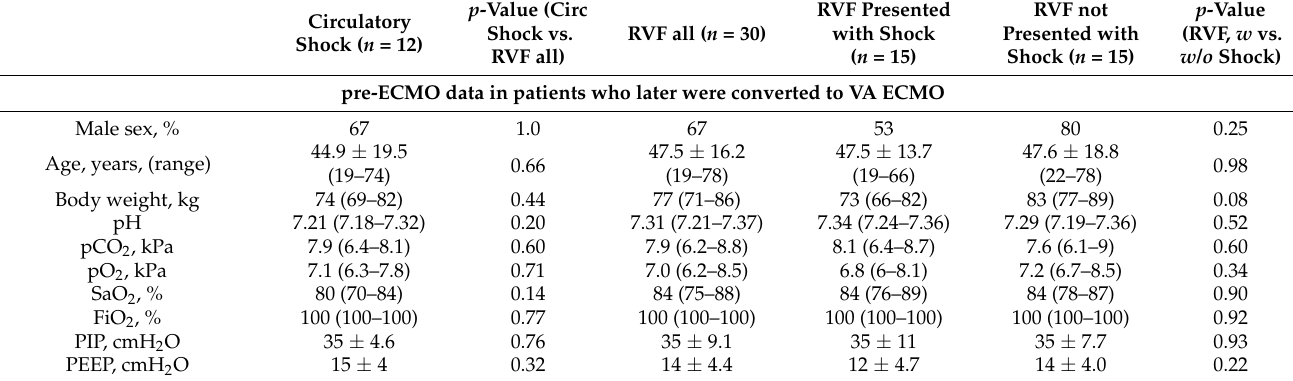
Table 4. Circulatory shock and right ventricular failure. Data for the groups converted from venovenous to venoarterial extracorporeal membrane oxygenation due to circulatory shock or right ventricular failure (RVF). The right part of the table presents the subgroups of RVF with concomitant shock or RVF with no circulatory shock. Normally distributed data are presented as mean ± SD, and non-parametric data as median (IQR). Differences for variable trajectories within same